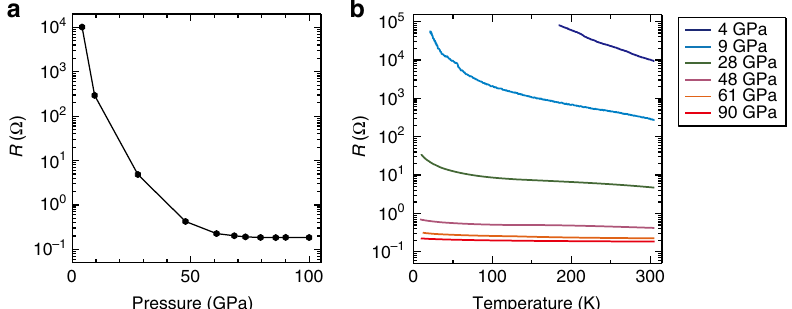
Fig. 3 Electrical resistance for SrVO 2 H under pressure. a Pressure dependence of resistance R at 300 K (sample SrVO 2 H-B). b Temperature dependence of resistance R at various